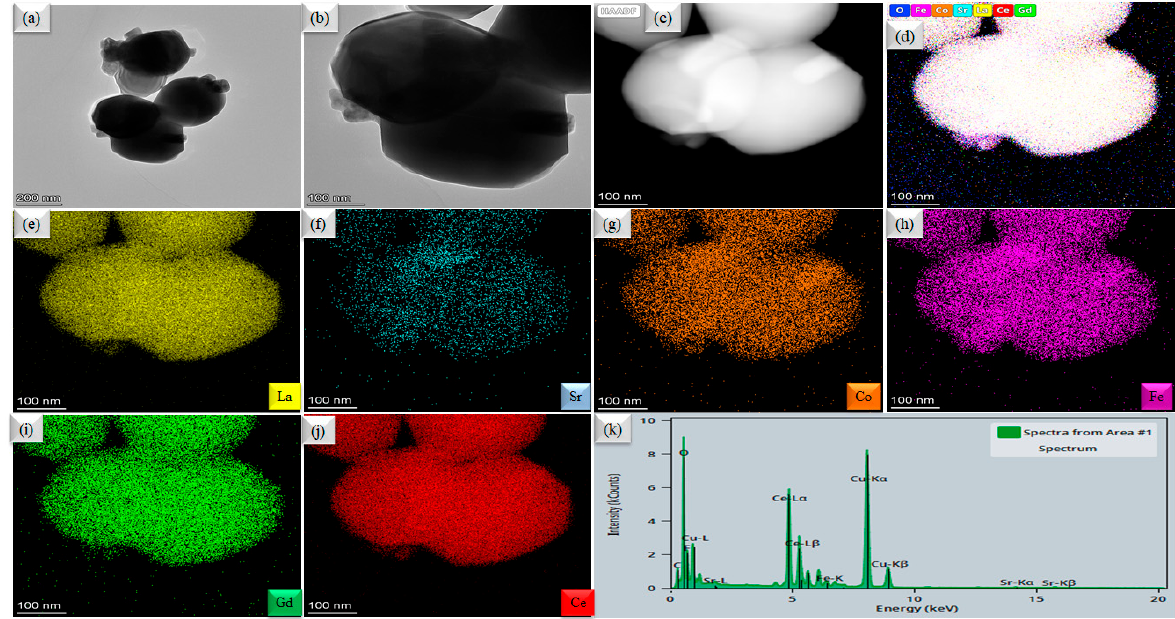
Figure 3. ( a , b ) HR-TEM image for the surface morphology of LSCF-GDC; ( c ) HAADF-STEM